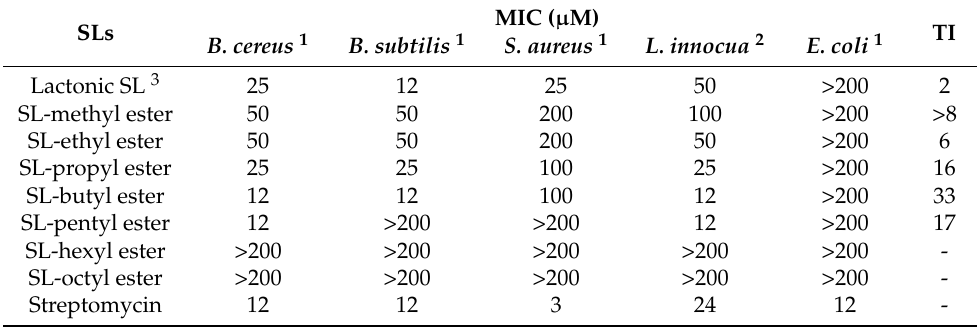
Table 1. Effect of SL-ester chain length on minimum inhibitory concentrations (MICs).